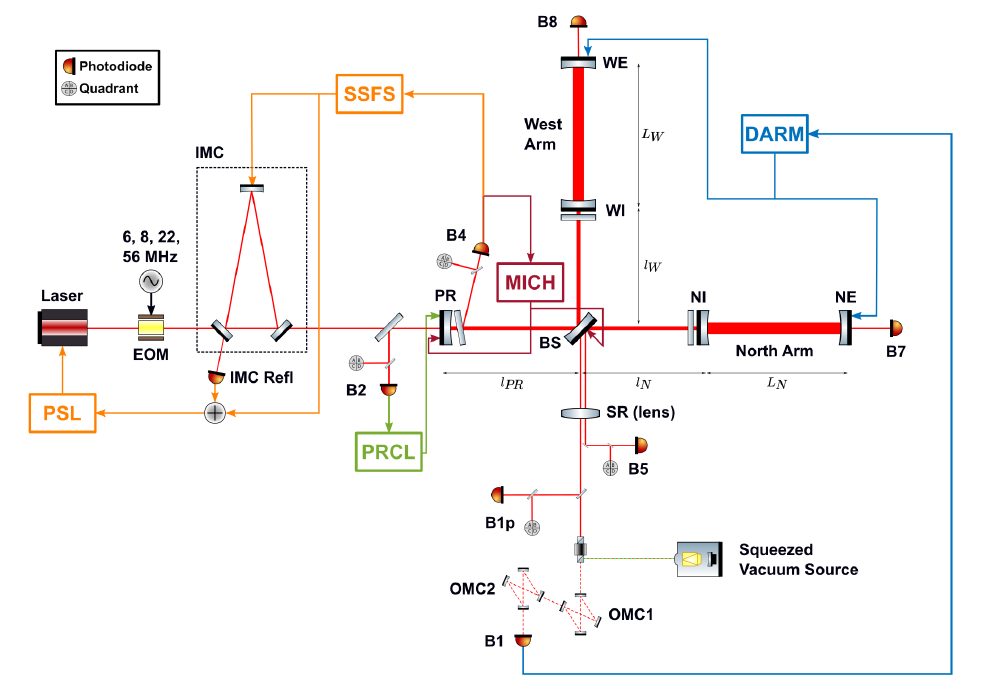
Figure 1. Optical layout of Advanced Virgo during O3. Each depicted Quadrant Photodiode (QPD) actually represents a set of two different physical sensors [6]. Acronyms used only in the plot: PSL (Pre-Stabilized Laser), IMC (Input Mode Cleaner), NI (North Input mirror), NE (North End mirror), WE (West End mirror), SR (Signal Recycling mirror). The image uses the graphic library from